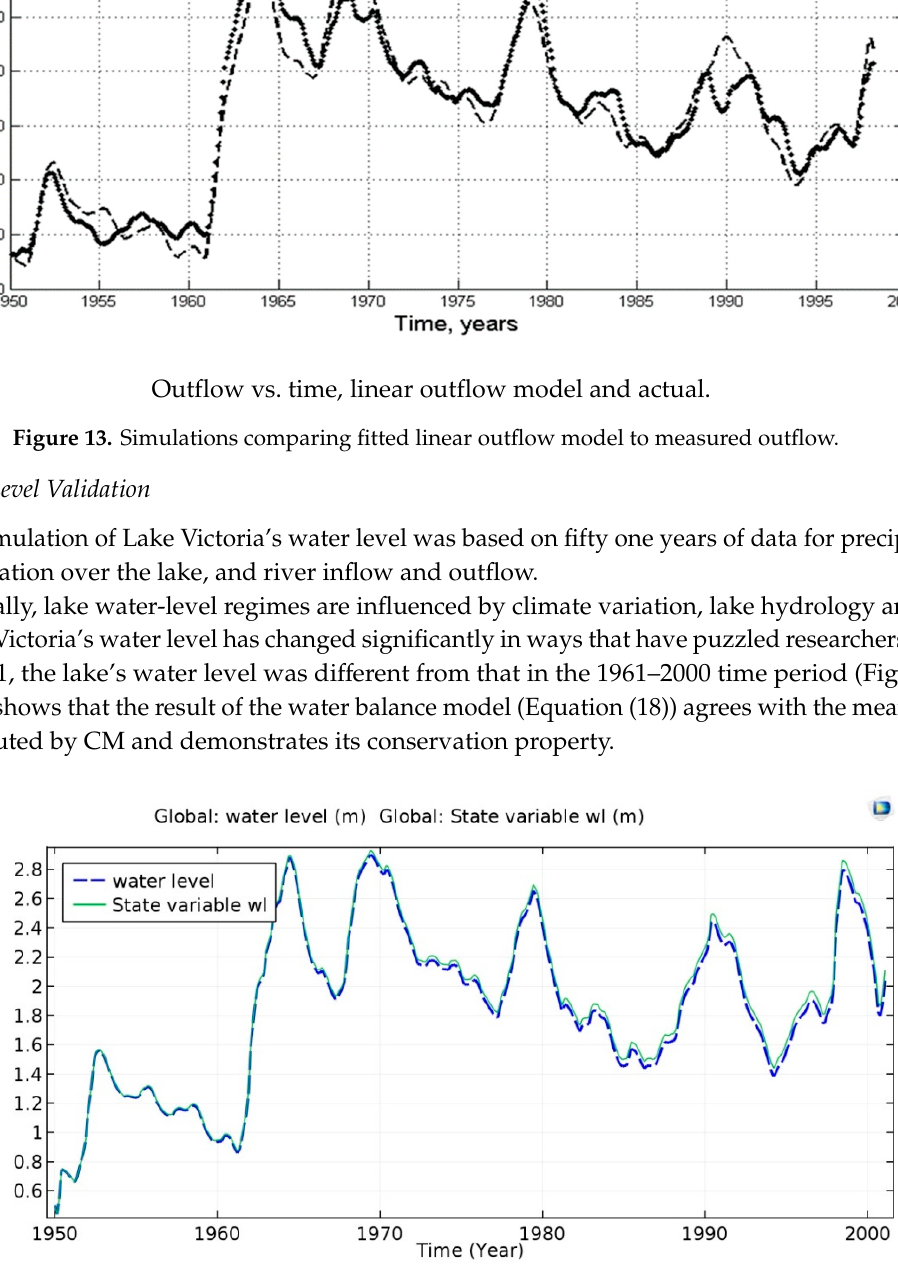
Figure 14. Mean water-level simulations showing that exact conservation property of the COMSOL finite element model.